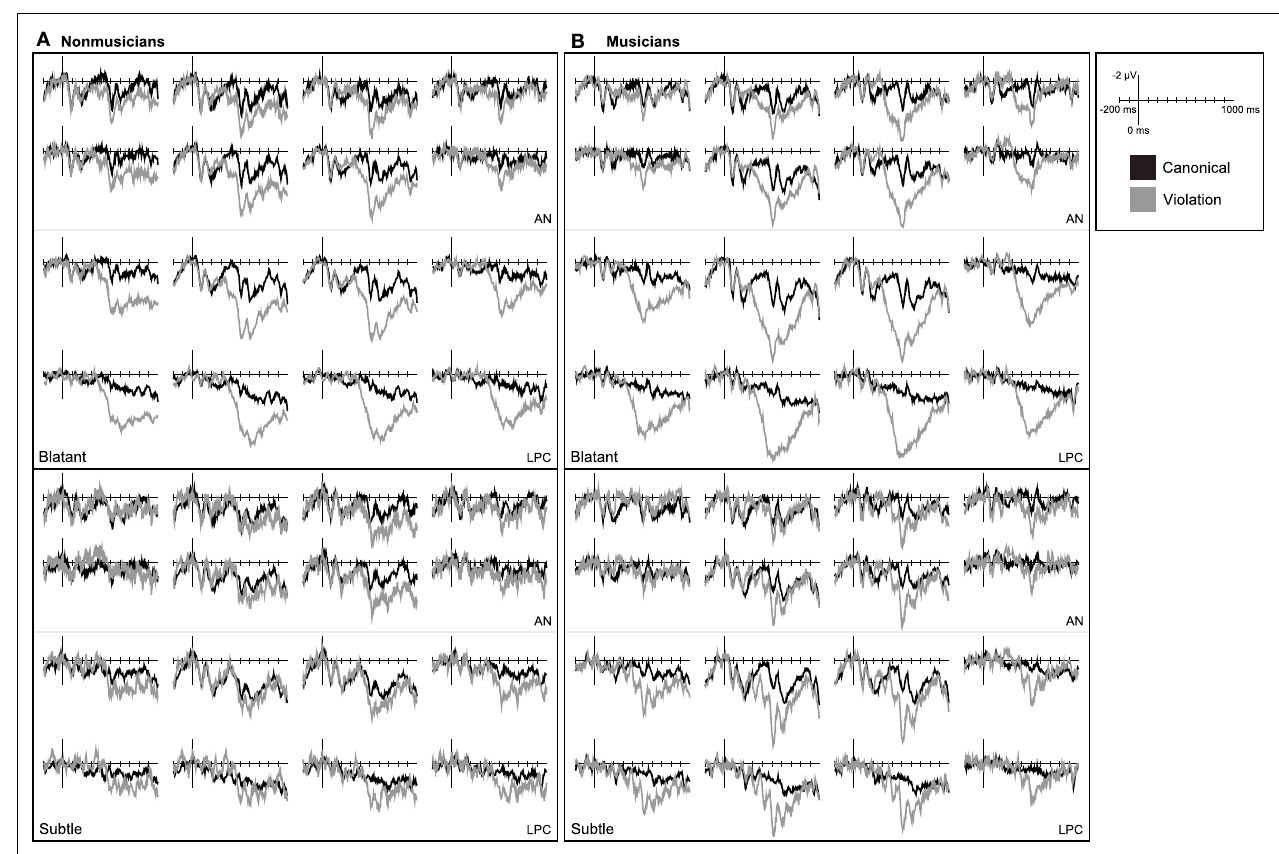
FIGURE 5 | Music ERPs. Grand average ERP waveforms elicited by critical chords in canonical and violation contexts measured in (A) non-musicians and (B) musicians. Data for chord substitutions from distantly related keys are shown on the top and from closely related keys on the bottom.